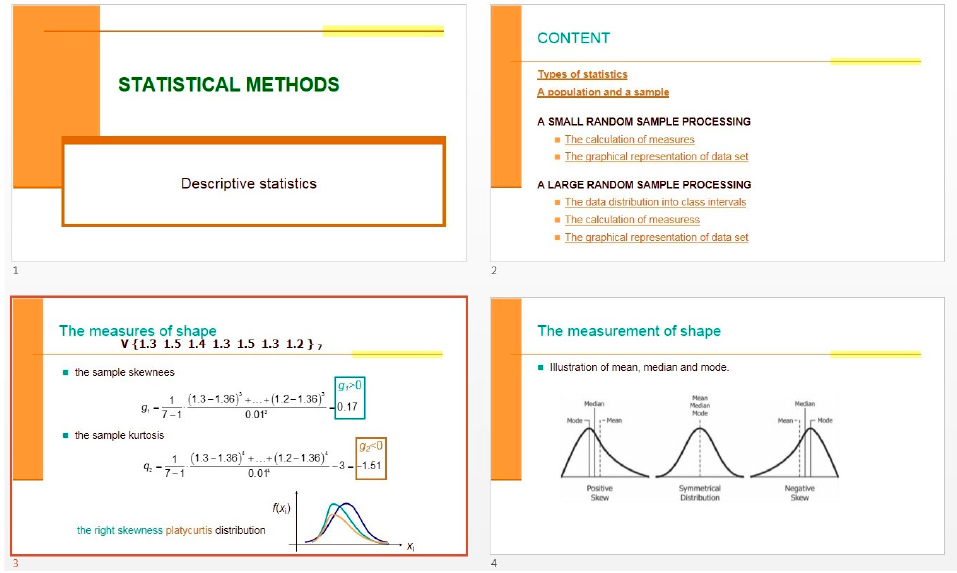
Figure 2. A sample of the part of the lecture